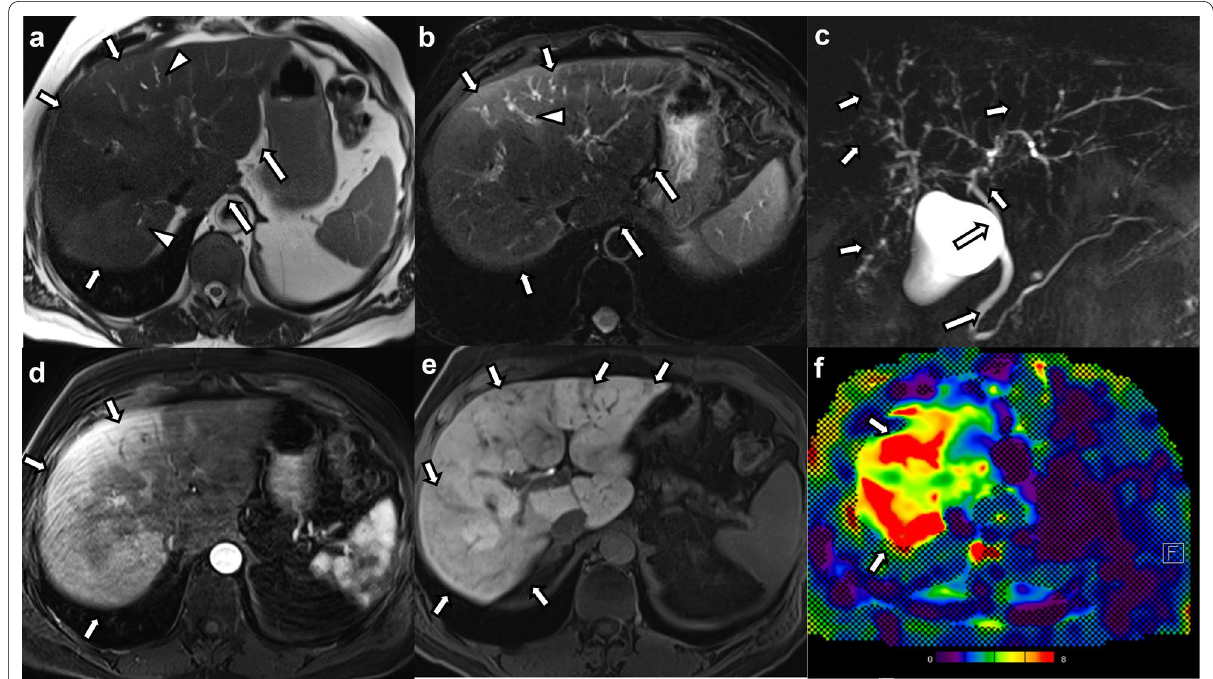
Fig. 4 61-year-old male patient with COVID-19-associated SSC after severe COVID-19 infection and prolonged ICU stay. a Axial non-fat-suppressed and ( b ) fat-suppressed T2-weighted images show mild hyperintense signal changes predominantly in the right hepatic lobe (arrows in a and b) with subtle bile duct dilatation (arrowheads in a and b ). The caudate lobe is enlarged, and the hepatic contours are rounded (long arrows in a and b ). c Maximum intensity projection MRCP image shows irregularities of the intrahepatic bile ducts with beading and multifocal structuring (arrows). The extrahepatic biliary tree is spared (long arrows). d Post-contrast images in the arterial phase show diffuse areas of patchy hyperenhancement especially in peripheral areas of the right hepatic lobe (arrows). d The post-contrast images in the hepatobiliary phase show patchy hypointense changes representing areas of decreased of hepatobiliary contrast agent uptake (arrows). f Color stiffness map from MR elastography shows increased stiffness of the liver parenchyma (arrows) as represented by the yellow to red color coding (mean liver stiffness was 6.4 kPa)